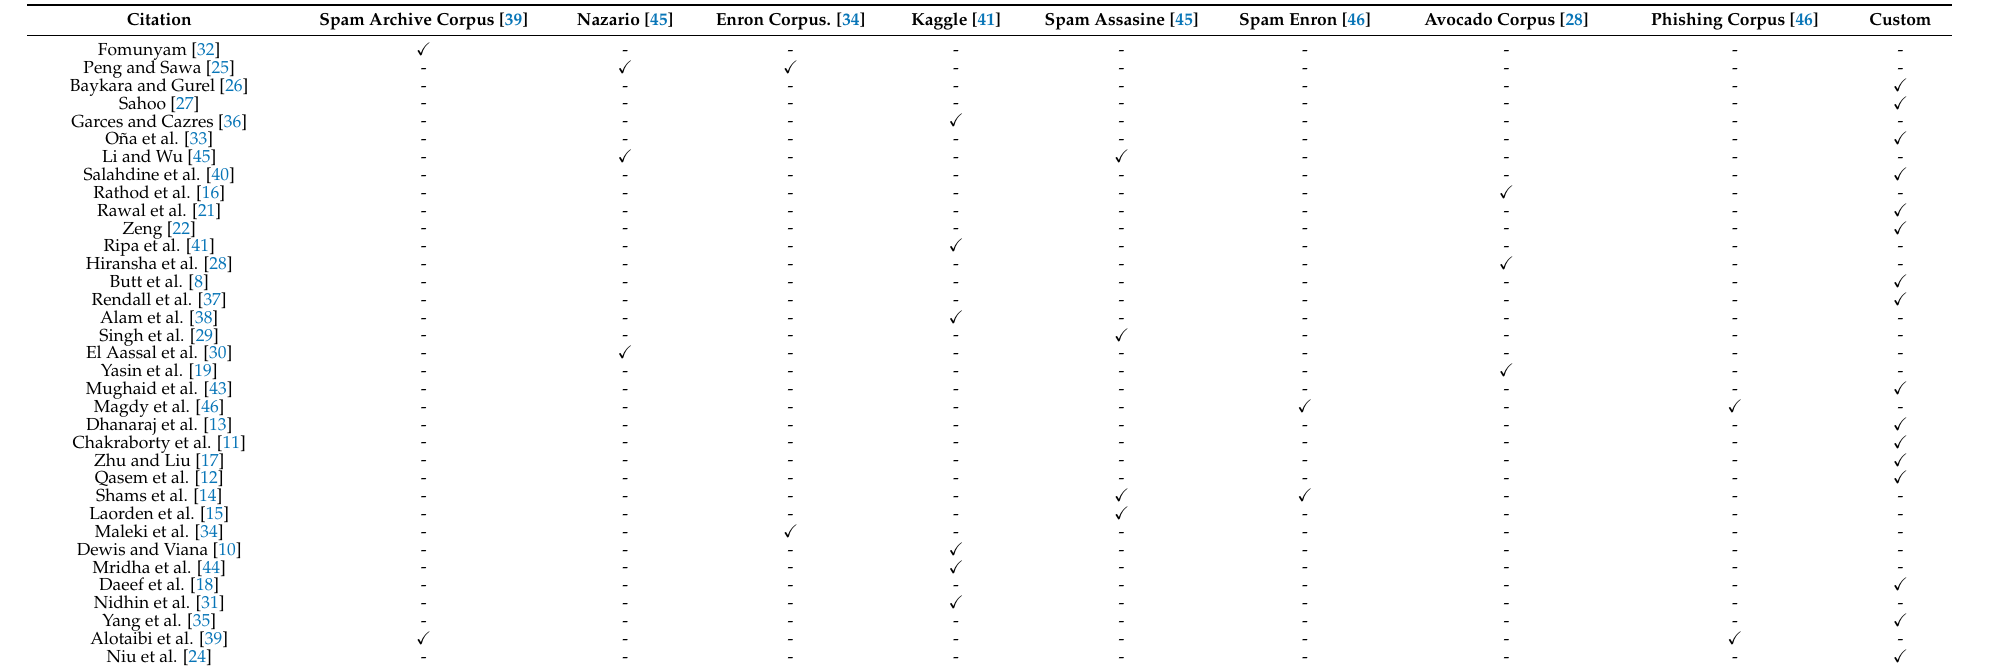
Table 6. Datasets utilised by various researchers to build BEC phishing detection